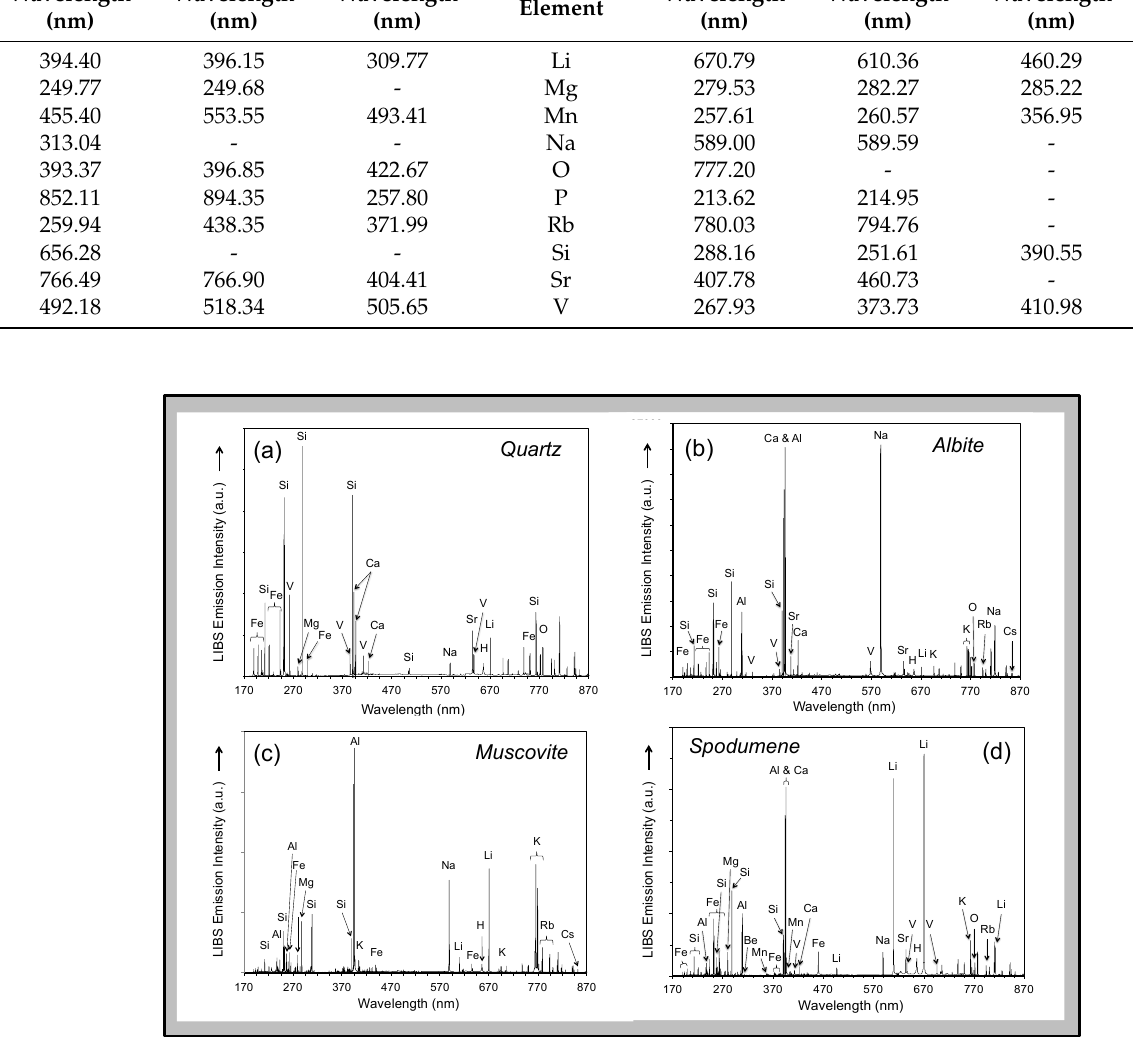
Figure 6. Handheld LIBS spectra for the primary pegmatite minerals quartz ( a ), albite ( b ), muscovite ( c ), and spodumene ( d ) from pegmatite outcrops on the Carolina Lithium Prroject prospect in Gaston County, N.C. The unlabeled peaks in the infrared portion of the spectrum between 700–870 nm are for the Ar purge gas used for the analysis.